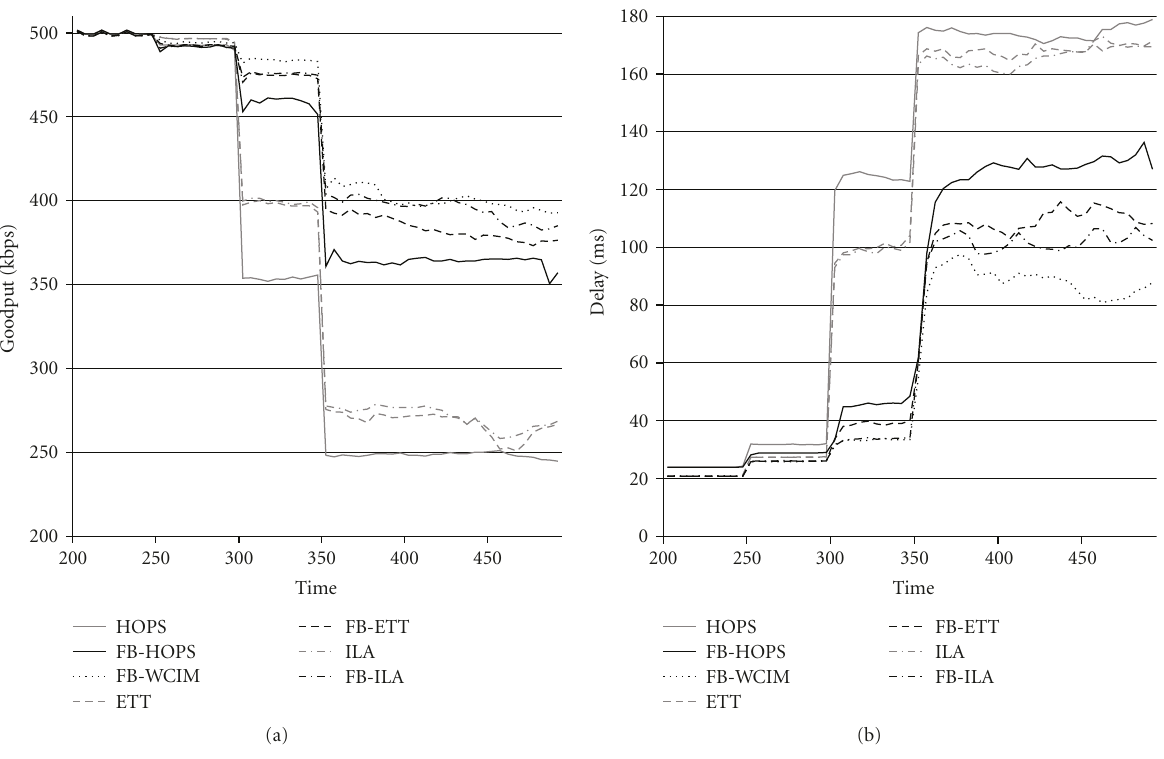
Figure 5: AODV versus FB-AODV. (a) Goodput per flow. (b) Delay per